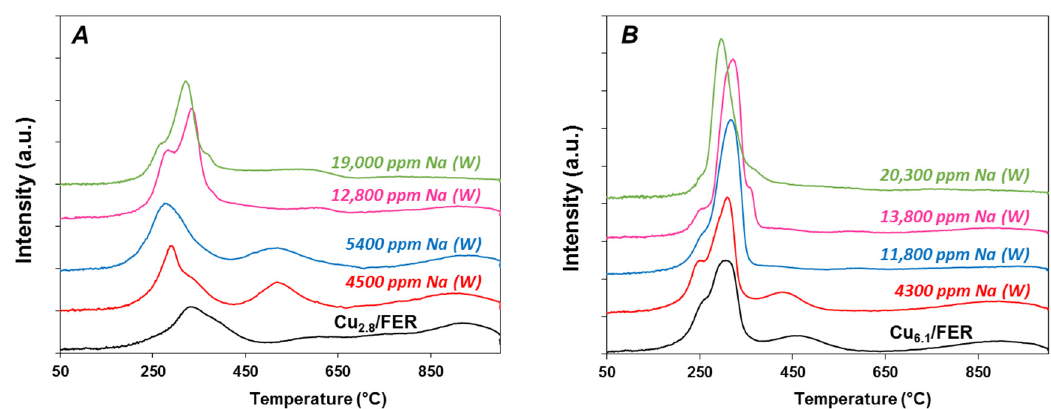
Figure 4. H 2 ‐ TPR profiles: Effect of Na loading impregnated in water (W) on ( A ) copper ‐ exchanged Figure 4. H 2 -TPR profiles: Effect of Na loading impregnated in water (W) on ( A ) zeolite Cu 2.8 /FER and ( B ) on over ‐ exchanged zeolite Cu 6.1 /FER.